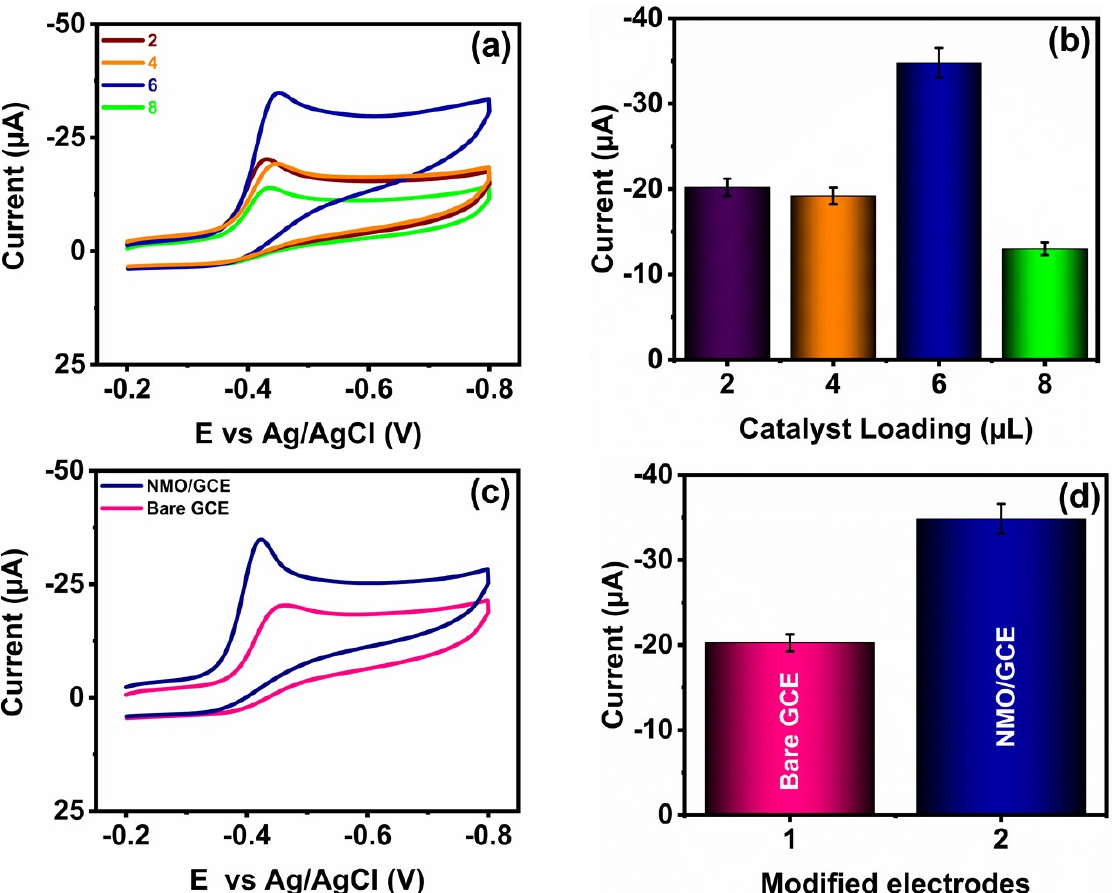
Figure 6. ( a ) CV response of different loading amounts of the catalyst NMO/GCE containing FZE (100 µM) at a scan rate of 50 mVs − 1 , ( b ) the dependence bar diagram for the reduction in the current response and loading of the catalyst, ( c ) CV response of NMO/GCE and bare GCE containing FZE (100 µM) at a scan rate of 50 mVs − 1 , and ( d ) the bar diagram of modified electrodes and reduction current response of FZE.